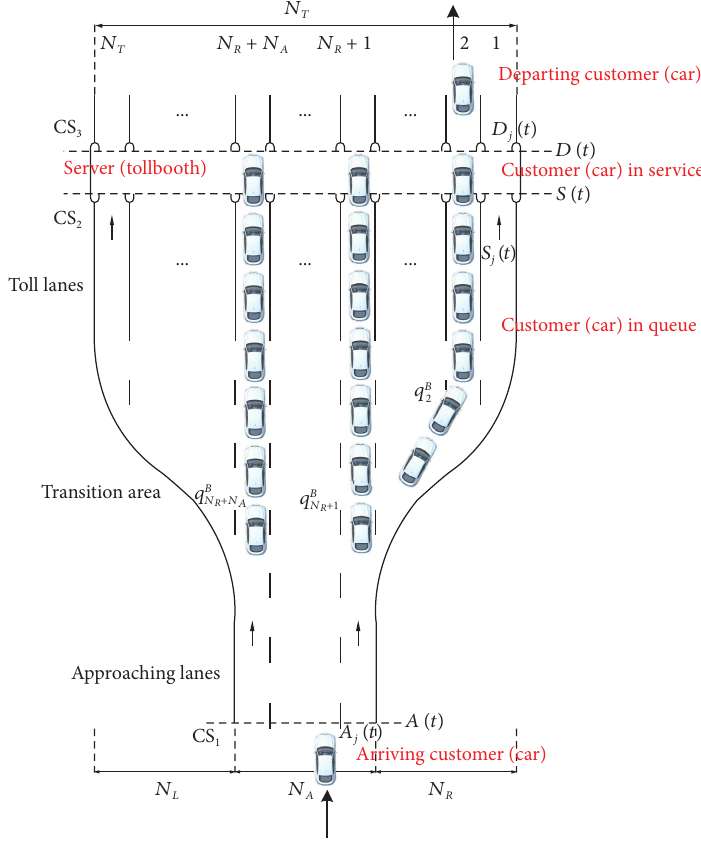
Figure 3: Queueing system for a toll